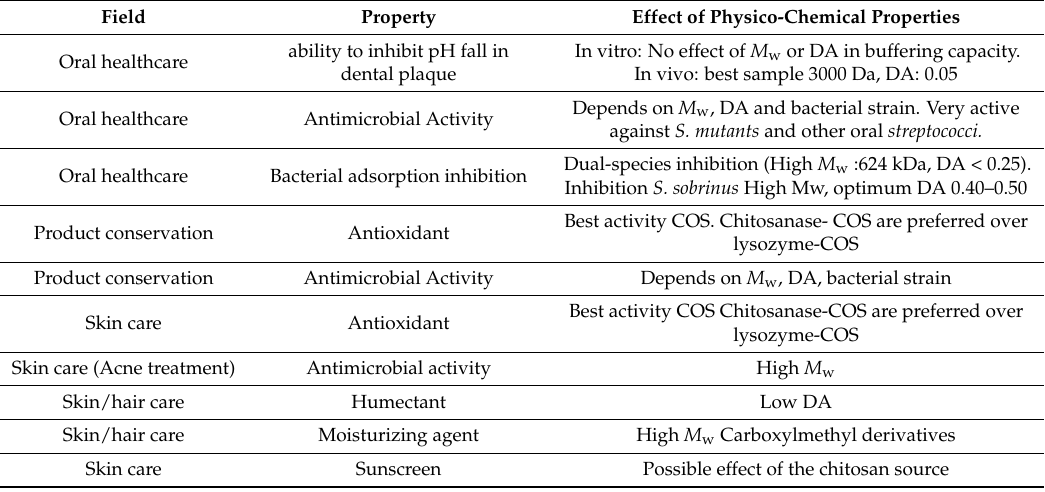
Table 13. Some general recommendations on chitin, chitosan and derivatives in cosmetics and cosmeceutical applications